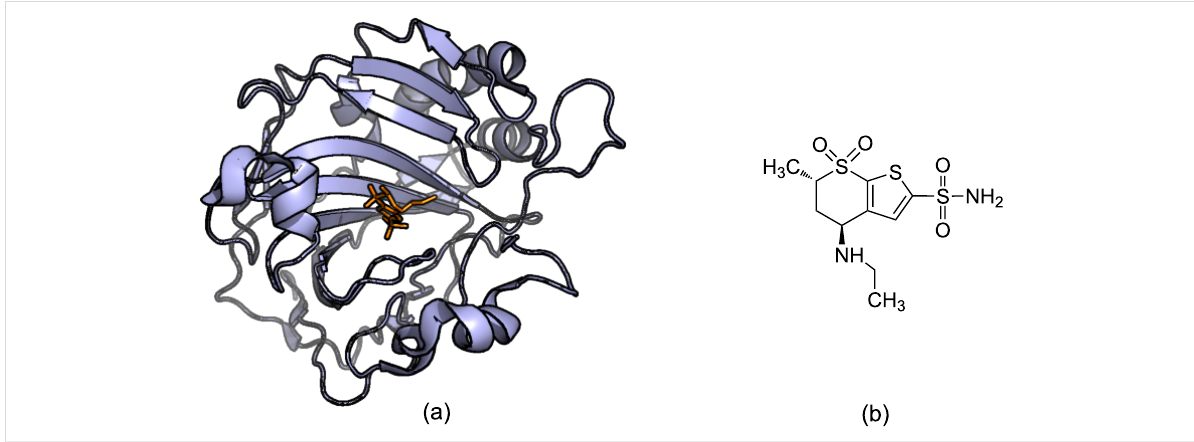
Figure 3: (a) The crystal structure showing the binding of Dorzolamide (orange) to carbonic anhydrase II (purple) (4M2U) (b) the structure of Dorzolamide. Dorzolamide is an FDA approved drug that targets carbonic anhydrase II to treat patience with glaucoma.